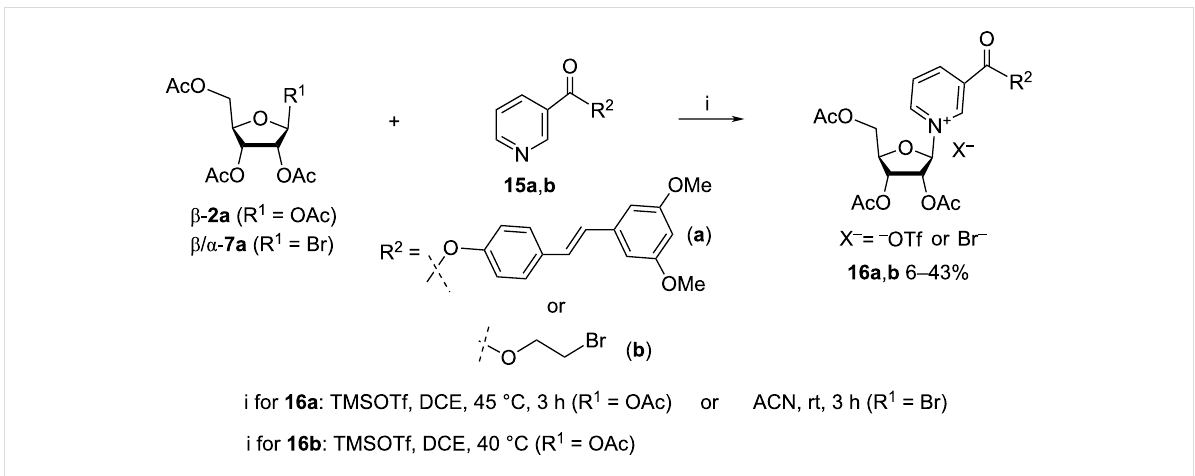
Scheme 9: Synthesis of triacetylated derivatives of NAR + by glycosylation of nicotinic acid esters with ribose tetraacetate or ribosyl-1-bromide tri-